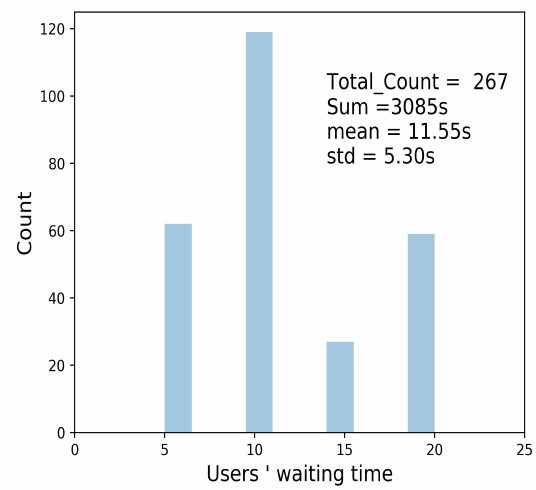
Figure 14. The statistics of users’ waiting time on elevator mapped by